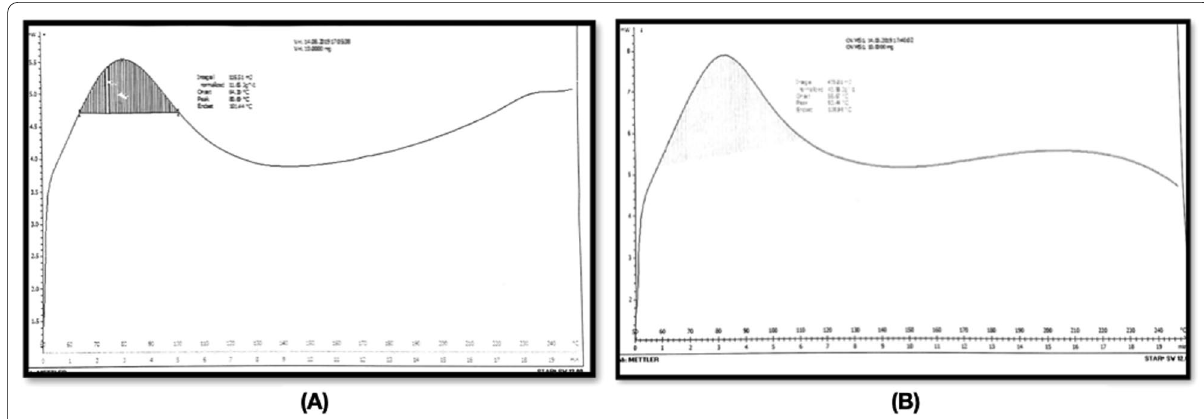
Fig. 7 Differential scanning calorimetry thermograms of microspheres. A Pure drug, B OVMS